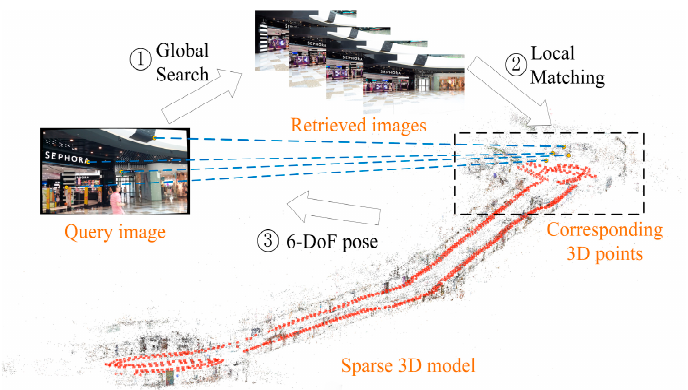
Figure 1. Hierarchical localization. Candidate images are retrieved from the database, and then the 2D key points of the query image are matched with the corresponding 3D points of the candidate images in model.